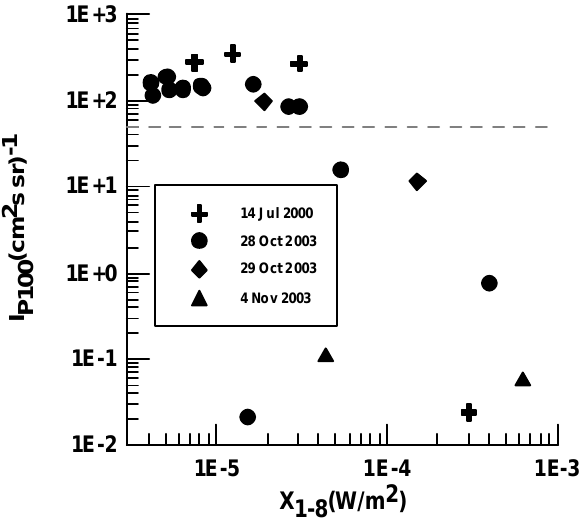
Figure 8. Scatter plot of the average >100 MeV SEP fluxes versus average solar 1-8 Å X-ray fluxes corresponding to the ROCSAT-1 passes at sunlit hemisphere during the considered solar events (depicted by vertical dashed lines in Figures 5-7). Horizontal dashed line restricts a lower threshold for the predominant SEP effects.